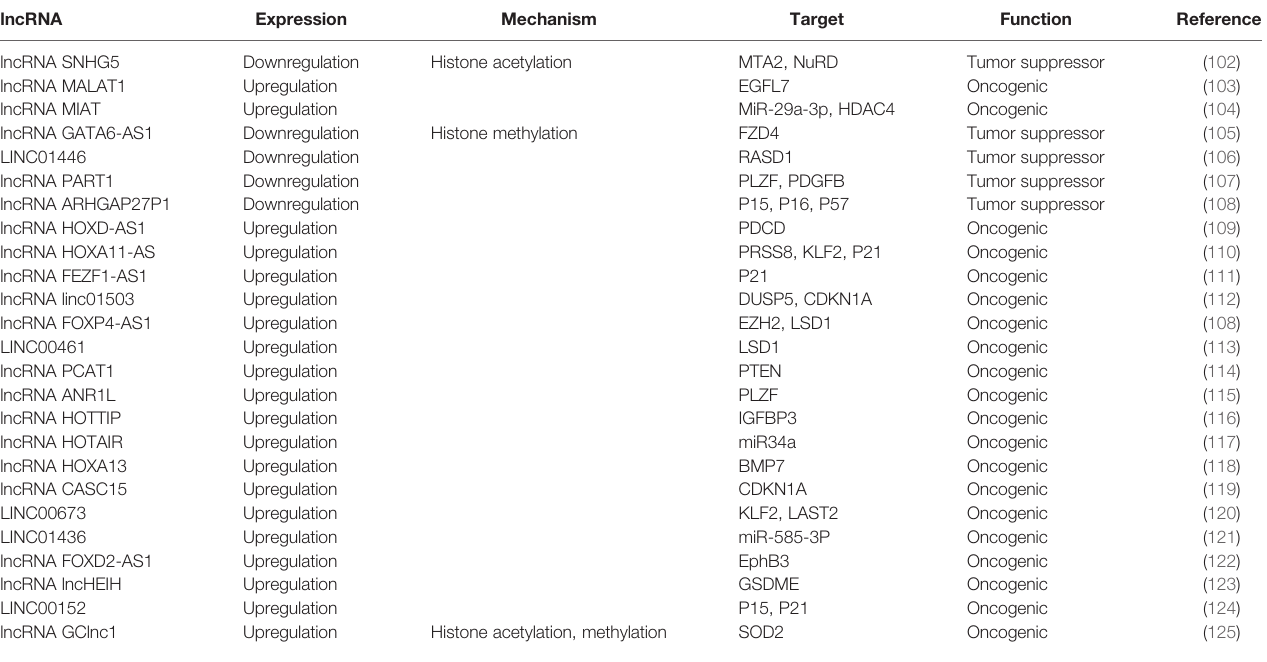
TABLE 2 | lncRNAs regulate histone modi fi cation in